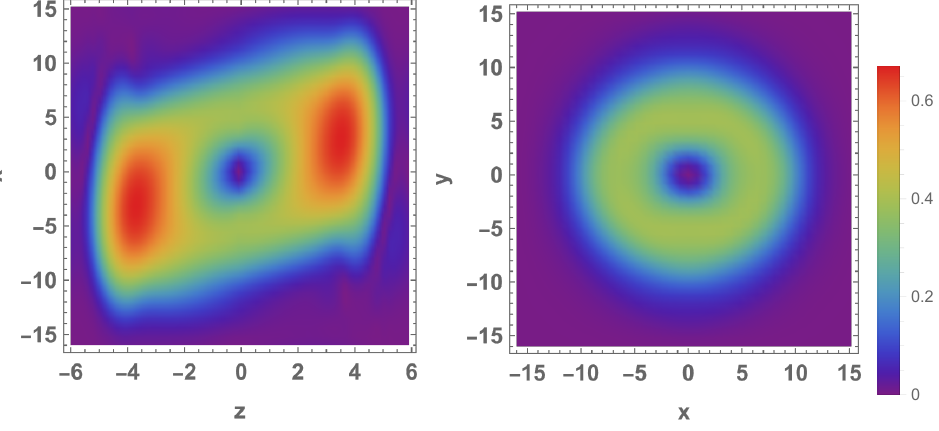
Figure 7 . The energy density T 00 through O ( (cid:15) ) (shown as a function of time at y = z = 0 ). We display the evolution of the energy density for various values of the transverse coordinate x .